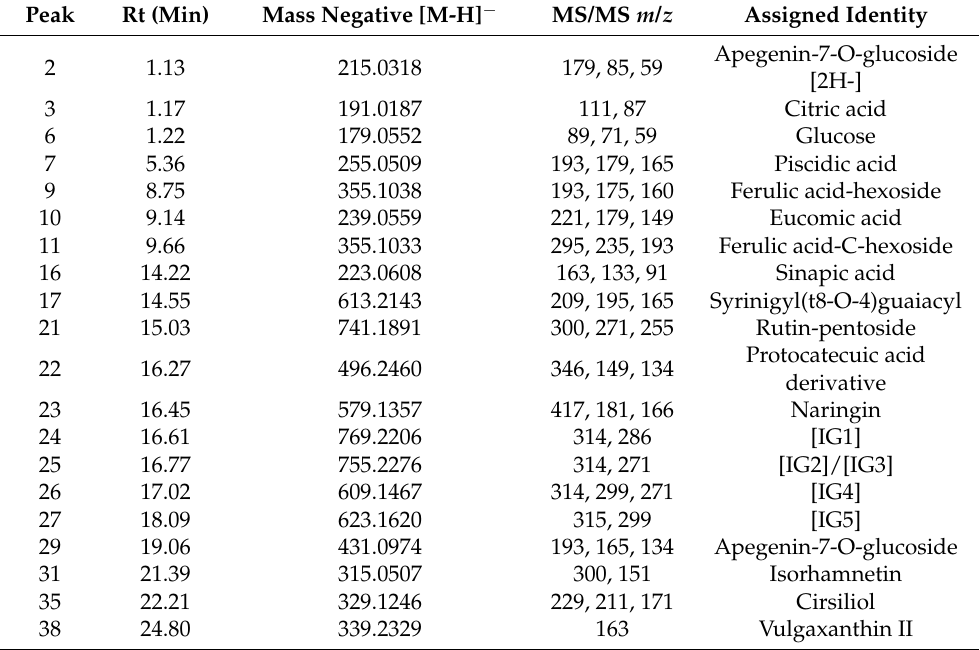
Table 5. Characterization of the identified compounds present in the analyzed OFP extracts (negative ion